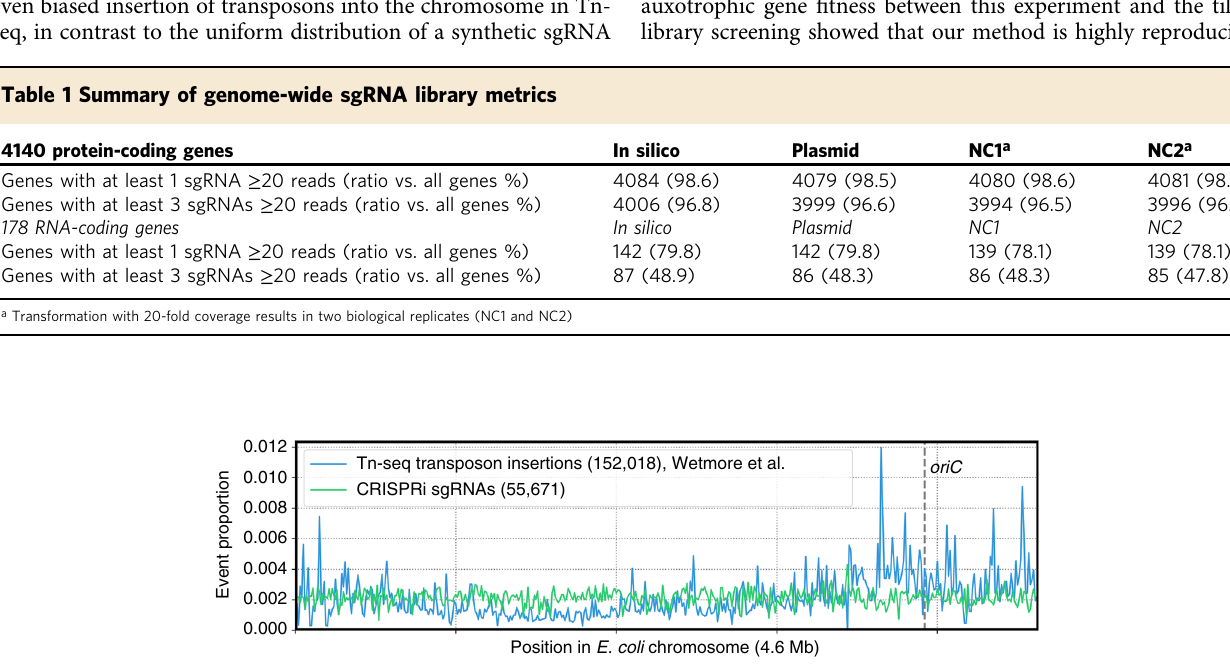
Fig. 2 Distribution uniformity of the genome-wide sgRNA library. Comparison of distribution uniformity between the genome-scale sgRNA library and a benchmark Tn-seq transposon insertion dataset along the E. coli chromosome. The proportion of event number (either sgRNA or transposon insertion densities) within each window over all events across the entire E. coli MG1655 chromosome is shown per 10-kb sliding